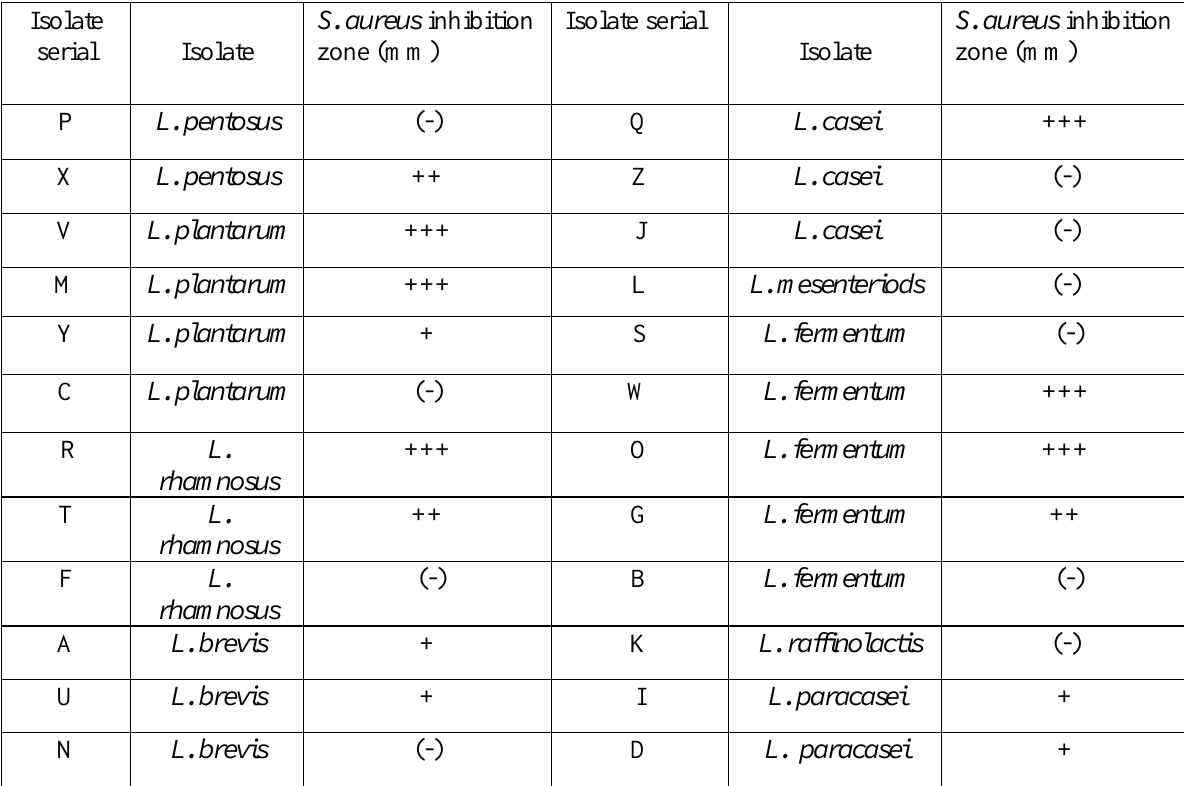
Table 4: Modified double layer method, antimicrobial activity of Lactobacillus against S. aureus.